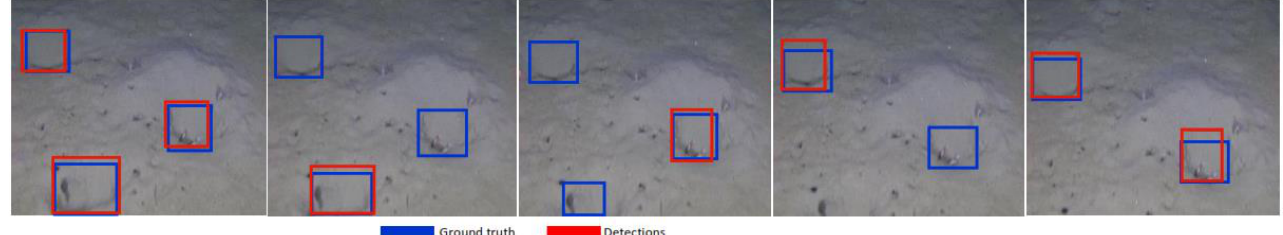
Figure 3. Ground truth (blue color, bounding boxes). The result of detector (Inception) (red color, bounding boxes). Due to camera angle variation and burrows appearance, the detector missed detections in consecutive frames.